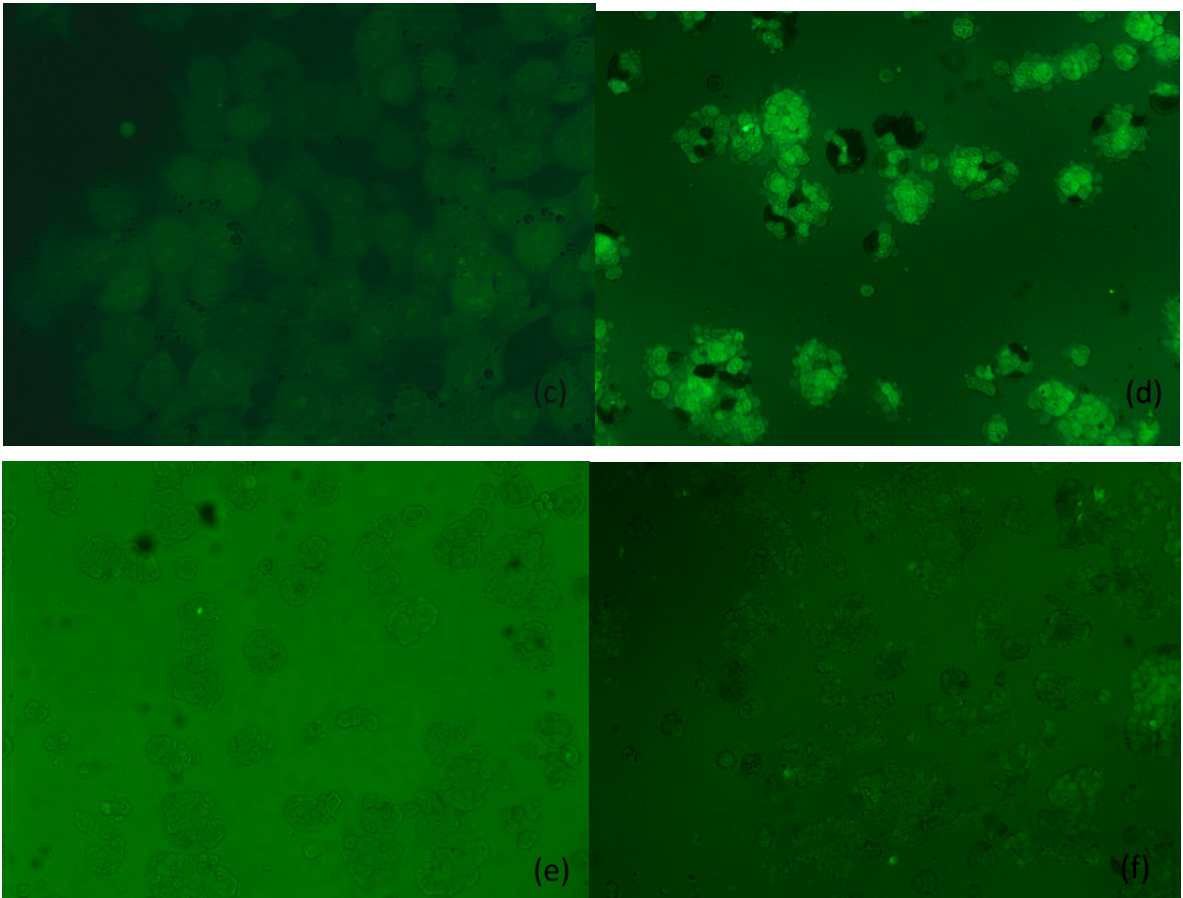
Figure 8. Fluorescence induced by ROS production in vitro in HT-29 cells ( a ), cells and H 2 O 2 ( b ) cells and IONP-THQ ( c ), cells, IONP-THQ and H 2 O 2 ( d ), cells and THQ ( e ) and cells, THQ and H 2 O 2 ( f ).